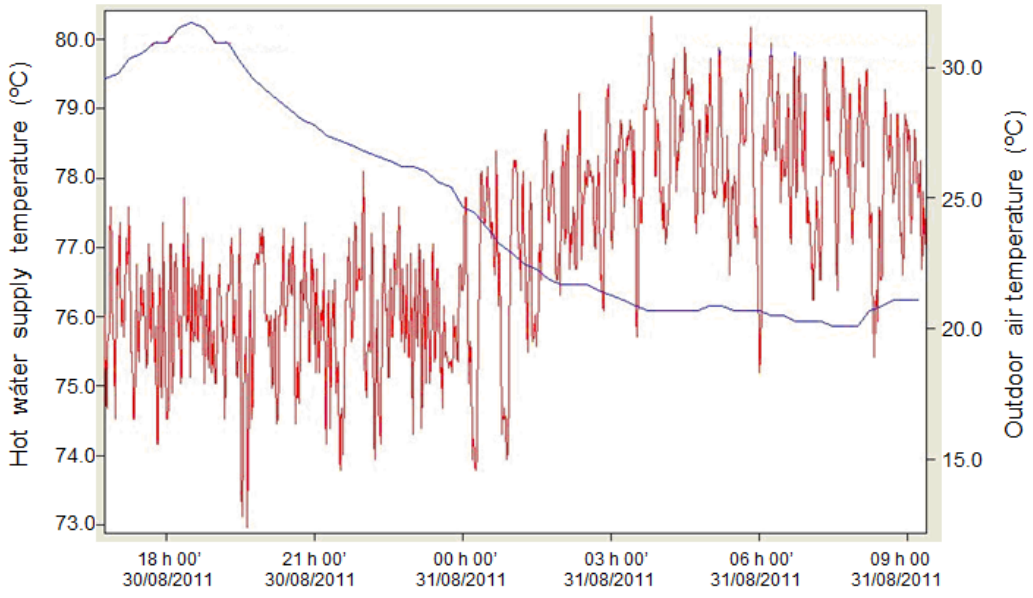
Figure 13. Boiler 5: Hot water supply temperature evolution (°C) and outdoor-air